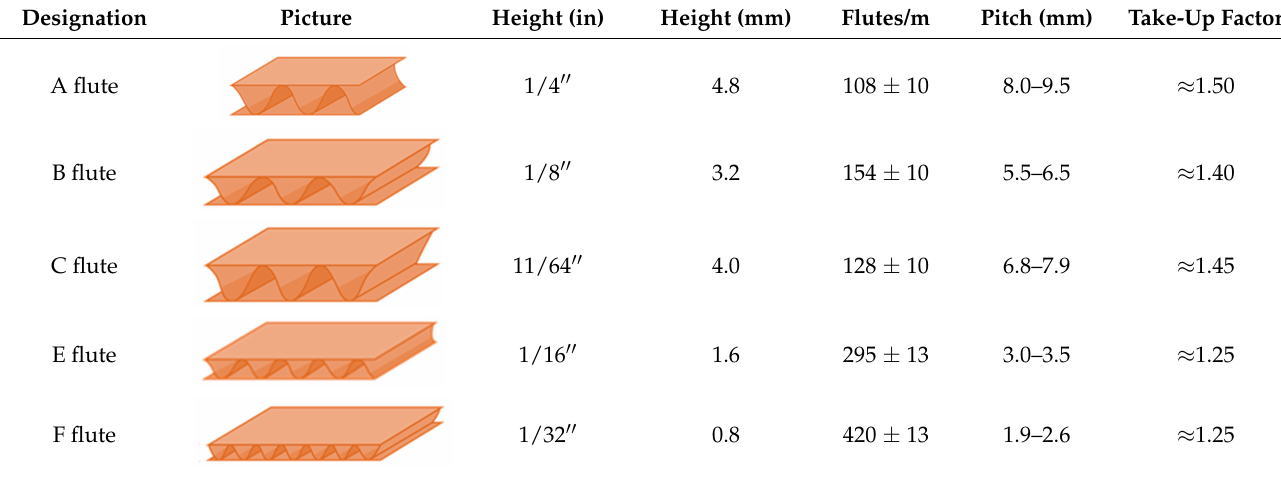
Table 1. Common flute types [15,23]. Reprinted with permission from ref. [12]. Copyright 2021